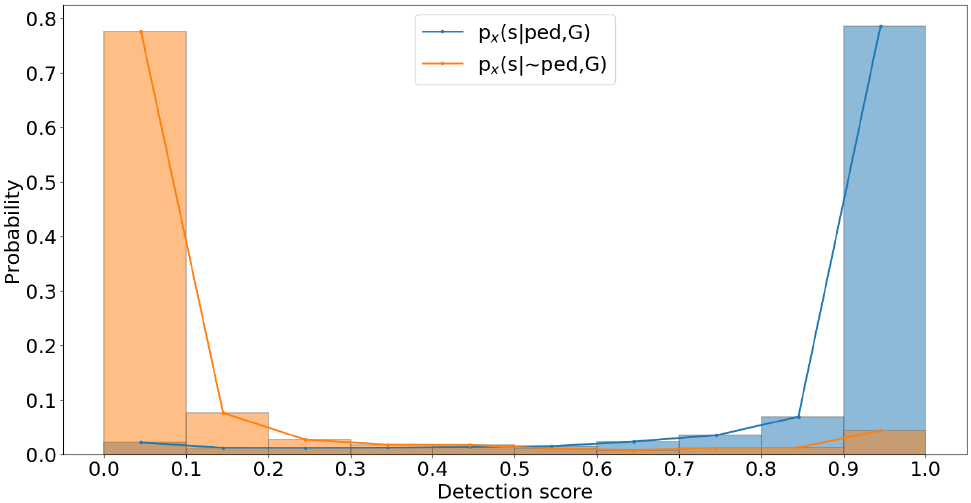
Figure 5. Approximated likelihood histograms from a dataset category: likelihood for true positives— p x ( s | ped , G ) , and false positives— p x ( s | ∼ ped , G ) .